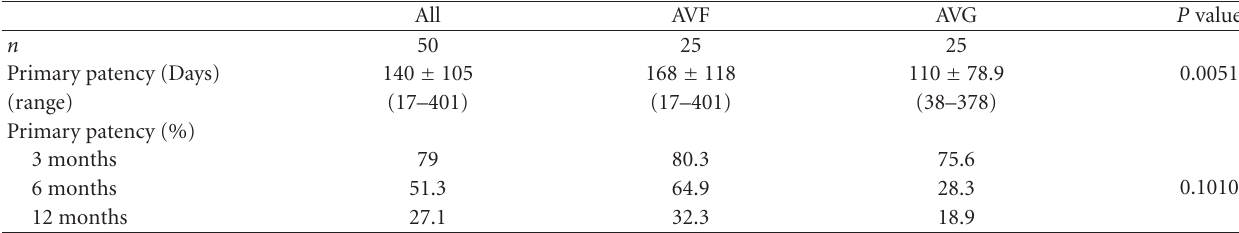
Table 2: Primary patency for SMART stent placement in AVF and AVG cases. There was no significant di ff erence in primary patency rates between AVF and AVG cases, but patency in AVG showed inferior to